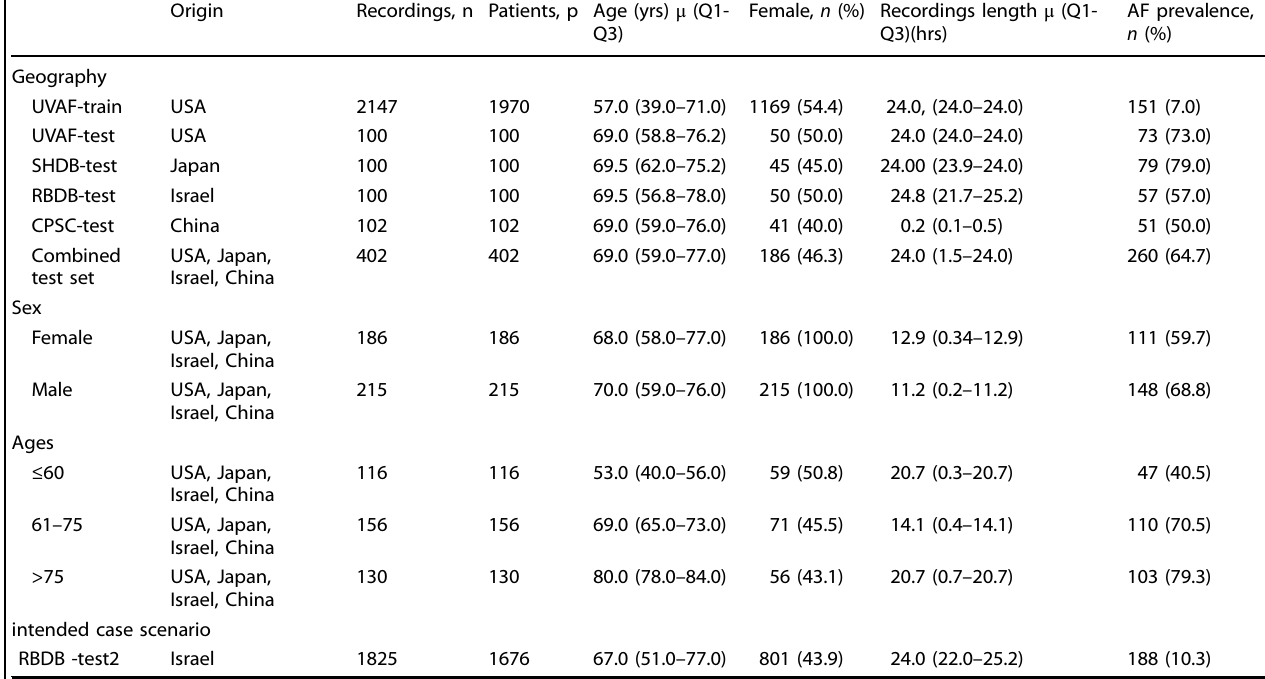
Table 1. Description of the population samples.